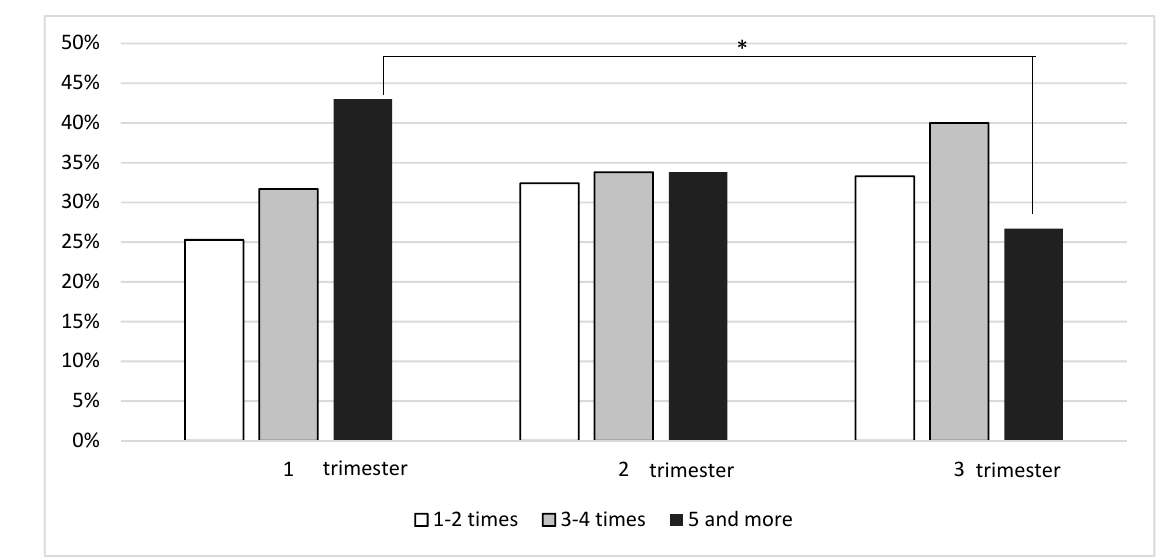
Figure 1. Declared frequency exercises per week in a group of physically active women with a twin pregnancy. * p < 0.05.